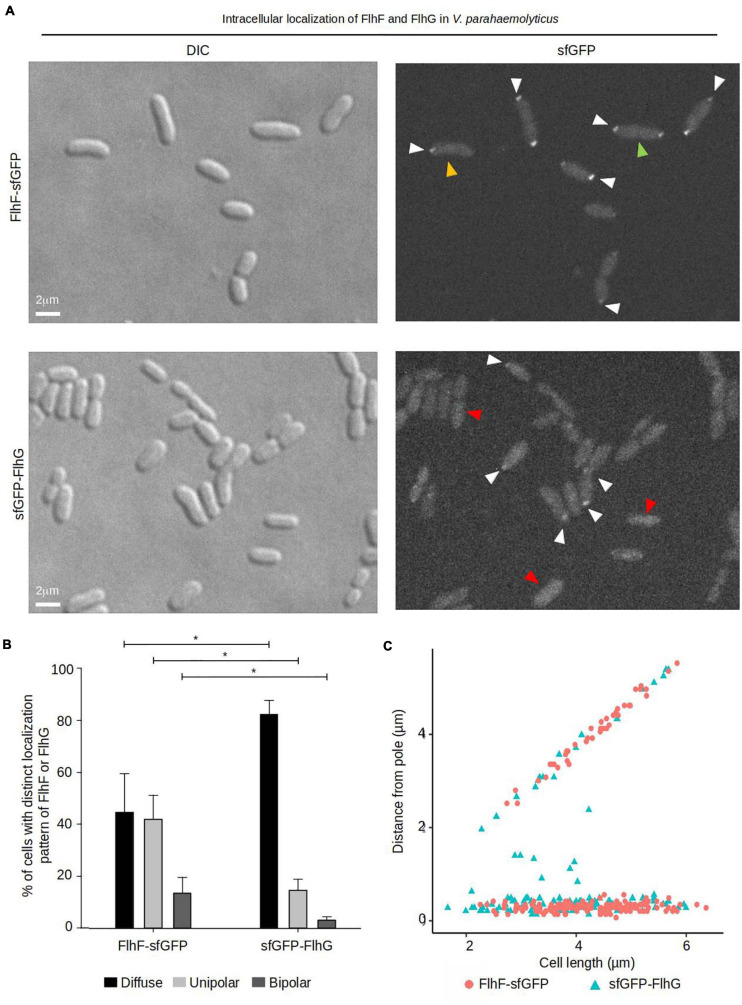
The intracellular localization of FlhF and FlhG in V. parahaemolyticus. (A) DIC and fluorescence microscopy of V. parahaemolyticus strains expressing FlhF-sfGFP or sfGFP-FlhG fusion proteins. White arrows indicate polar foci, orange arrows = unipolar foci, green arrows = bipolar foci, red arrow = diffuse. (B) Bar graph showing the percentages of cells with fluorescent foci at one, two, or no poles. Asterisk, *, indicates p < 0.05, tested with ANOVA + Tukey HSD. (C) Graph depicting the distance of FlhF-sfGFP clusters from the cell poles as a function of cell 2length.